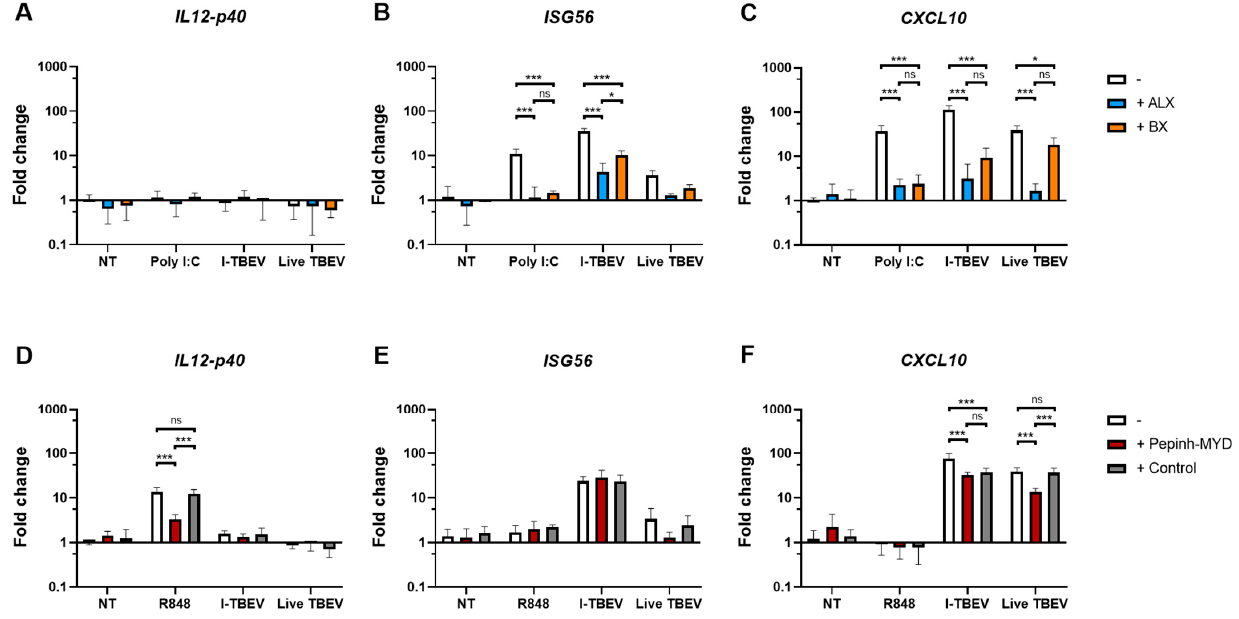
Figure 4. Gene expression levels in PBMCs stimulated with I-TBEV or live TBEV in the presence of inhibitors. PBMCs from 3 healthy donors were pre-incubated with RLR inhibitors (ALX, 50 μ g/mL, and BX, 2 μ M) for 1 h ( A – C ) or with MyD88 inhibitor (Pepinh-MYD, 10 μ M) and its peptide control (Control) for 6 h ( D – F ). Afterwards, the cells were treated for 24 h with Poly I:C (0.5 μ g/mL), R848 (10 μ g/mL), I-TBEV (0.24 μ g/mL) or live virus (MOI 10). Following stimulation, the cells were lysed and changes in gene expression were analyzed by RT-qPCR. Results are from 3 replicates. Levels of significance: ns: p > 0.05; *: p ≤ 0.05 and ***: p ≤ 0.001. Absence of labels indicates non-significant differences.